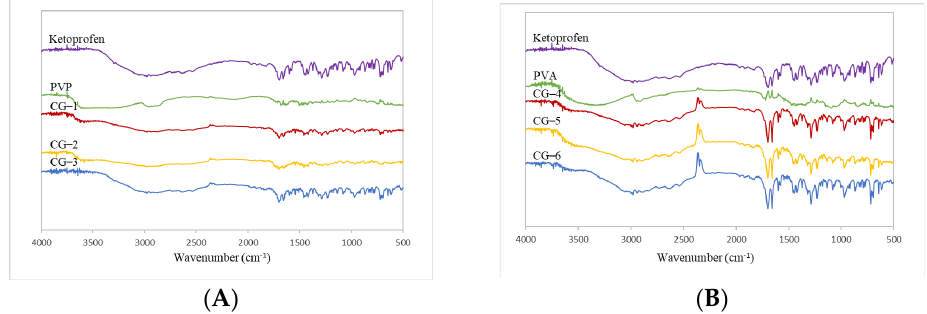
Figure 4. ( A ) Co − grinded Ketoprofen FTIR Spectrum with PVP and ( B ) Co − grinded Ketoprofen FTIR Spectrum with PVA.